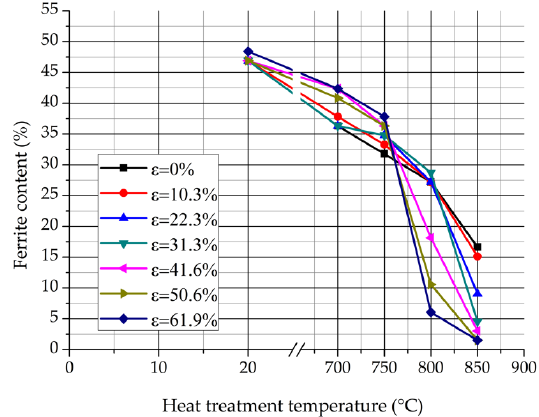
Figure 5. Set-up of the AC